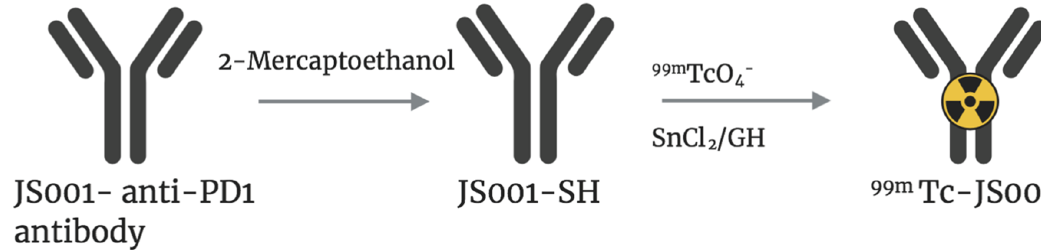
Figure 1. JS001-SH was obtained after reaction of the antibody with 2-mercaptoethanol. Direct radiolabeling of JS001-SH (as shown above) was achieved by reacting JS001-SH with Na[ 99m Tc0 4 ] and SnCl 2 in PBS buffer. Adapted from [16].